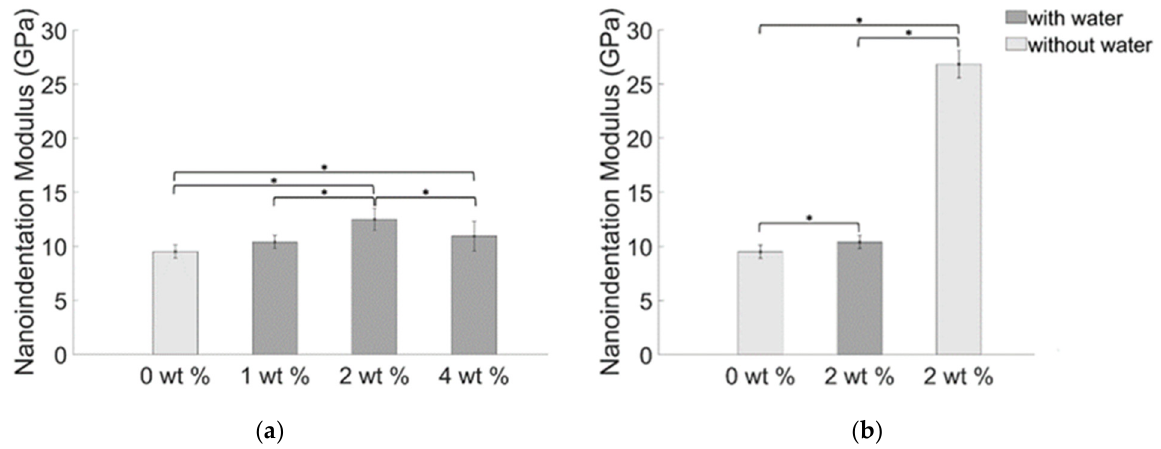
Figure 12. Average values of the nanoindentation modulus of BiONPs composite: ( a ) with water and ( b ) without water. Statistically significant differences ( p < 0.05) between cements with different filler concentration are also indicated through the asterisk.